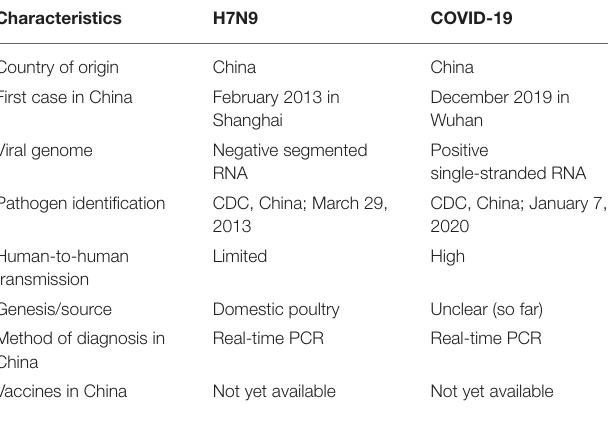
TABLE 1 | Characteristics of the H7N9 avian influenza and coronavirus disease 2019 in China.